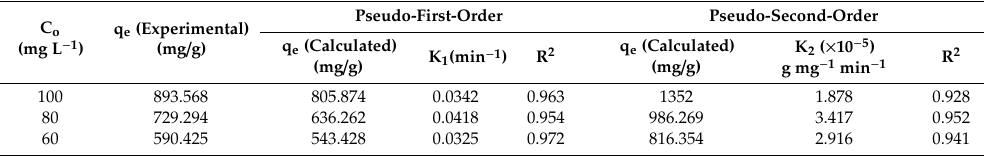
Table 5. Values of kinetic constants and coe ffi cients for various kinetic